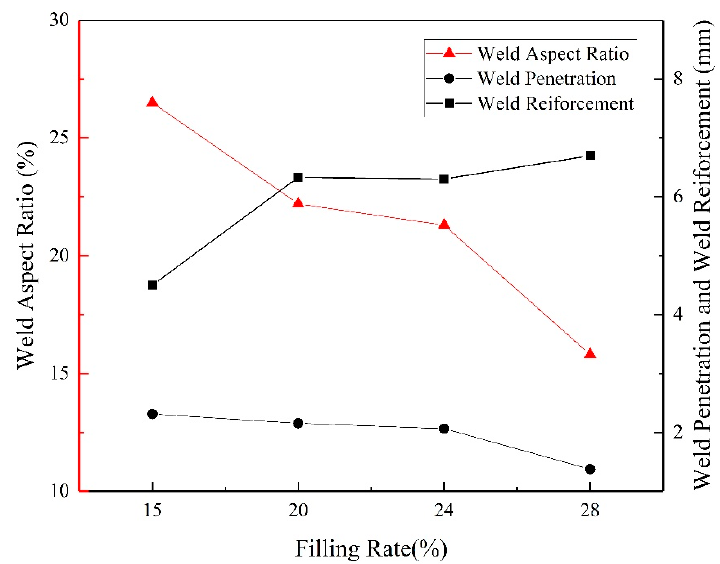
Figure 12. The cross sections of welding joints with different filling rate. ( a ) 15% filling rate; ( b ) 20% filling rate; ( c ) 24% filling rate; ( d ) 28% filling rate.